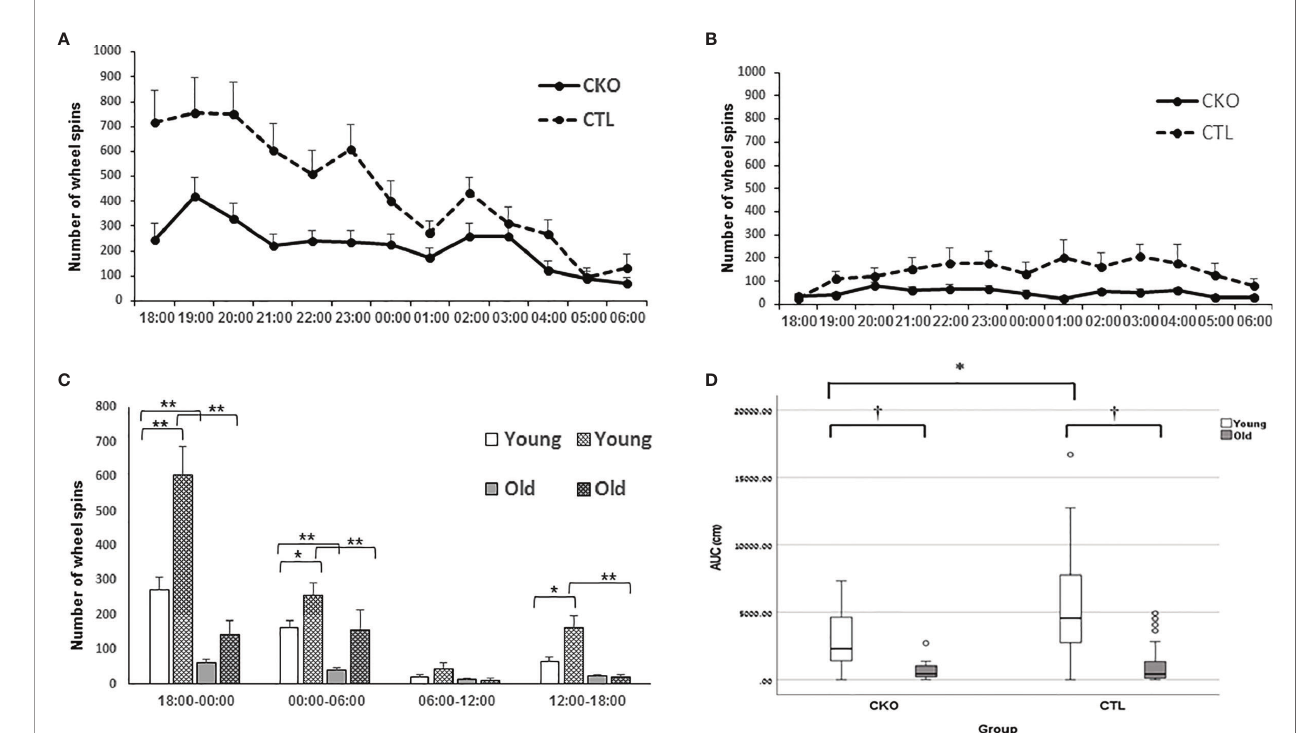
FIGURE 4 | Results of the free running wheels. The average sum of hourly wheel revolutions (wheel spins) of (A) young and (B) old mice old during the night cycle. (C) Hourly sum of wheel revolution according to 6 hours interval during the day and night (*p < 0.05; **p = 0.001). (D) AUC analysis of the hourly sum of wheel spins of the active period (night) presented in A and B (*p < 0.05; † < 0.01).